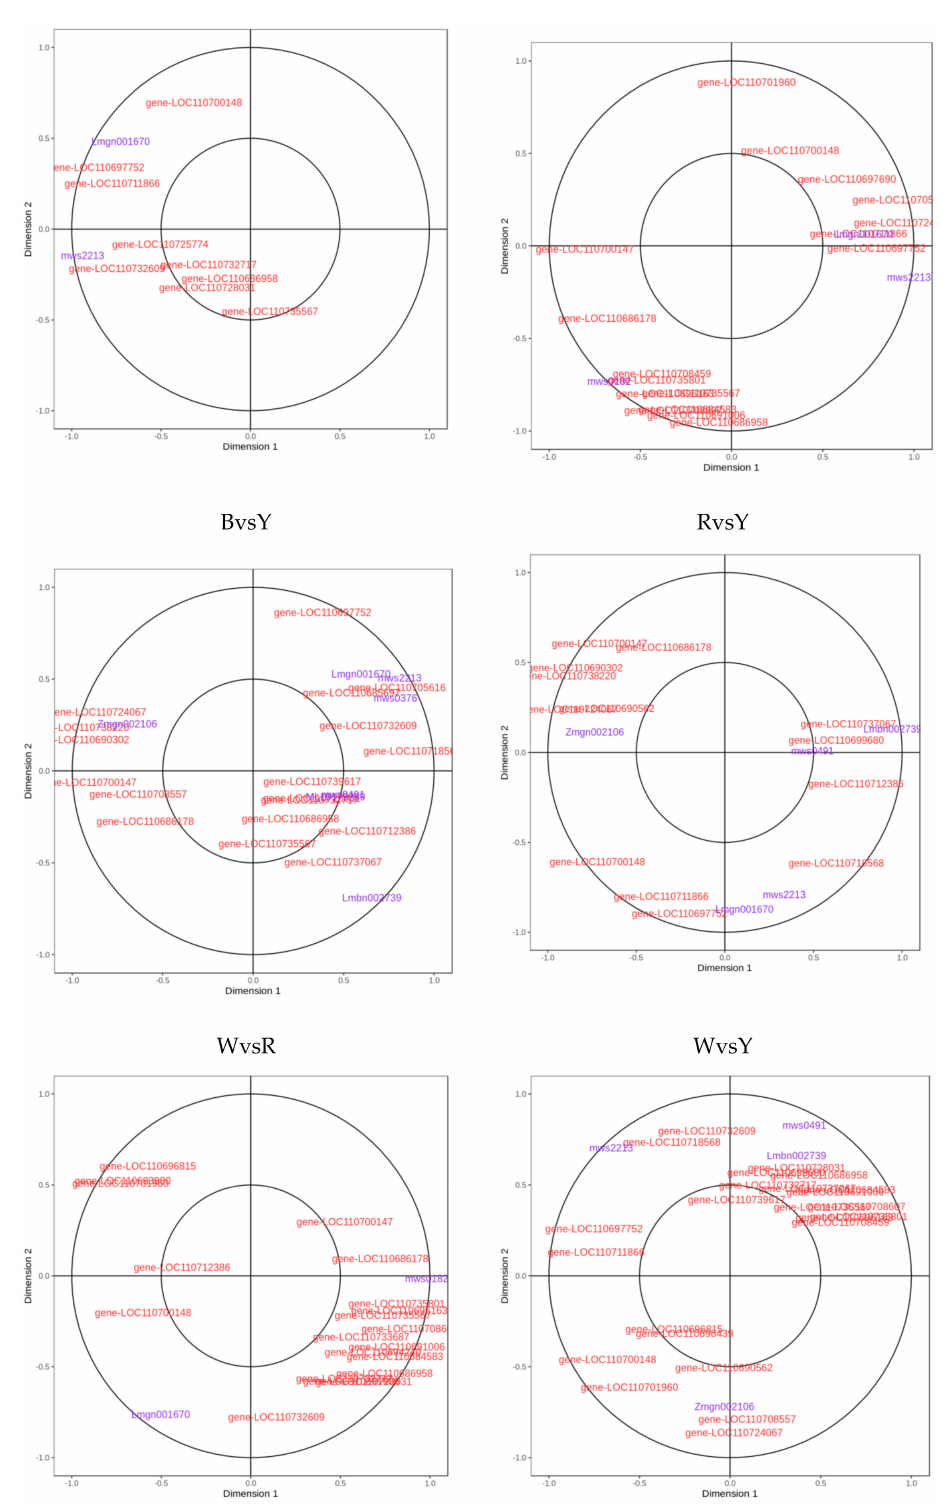
Figure 2. CCA results of phenylalanine metabolism pathway in different quinoa cultivars. Note: Four regions are distinguished by crosses in the figure. Within the same region, the farther away from the origin, the closer the distance to each other and the higher the